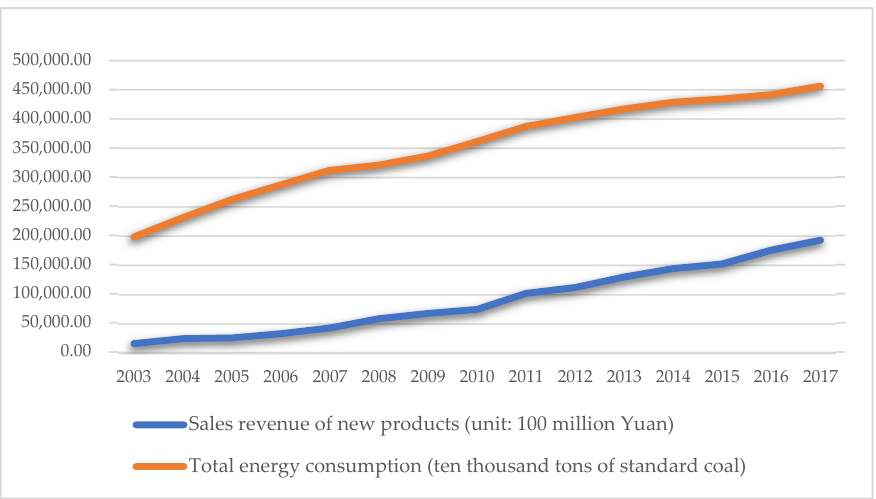
Figure 3. 2003–2017 sales revenue of new products and total energy consumption (data source: China National Bureau of Statistics).